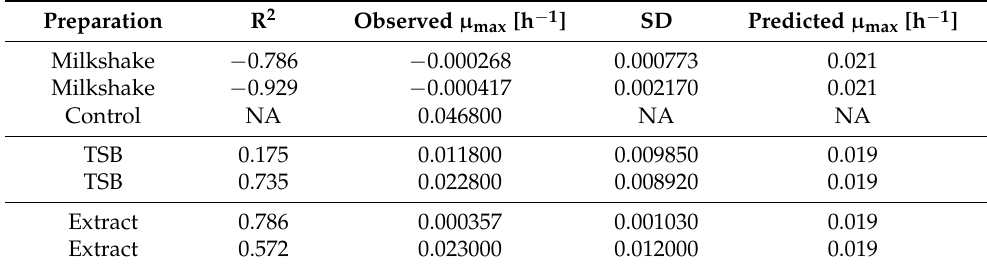
Table A3. Observed and predicted values of maximum growth rate for refrigerated (9 ◦ C) samples of goji berry milkshake, extract, and TSB medium.